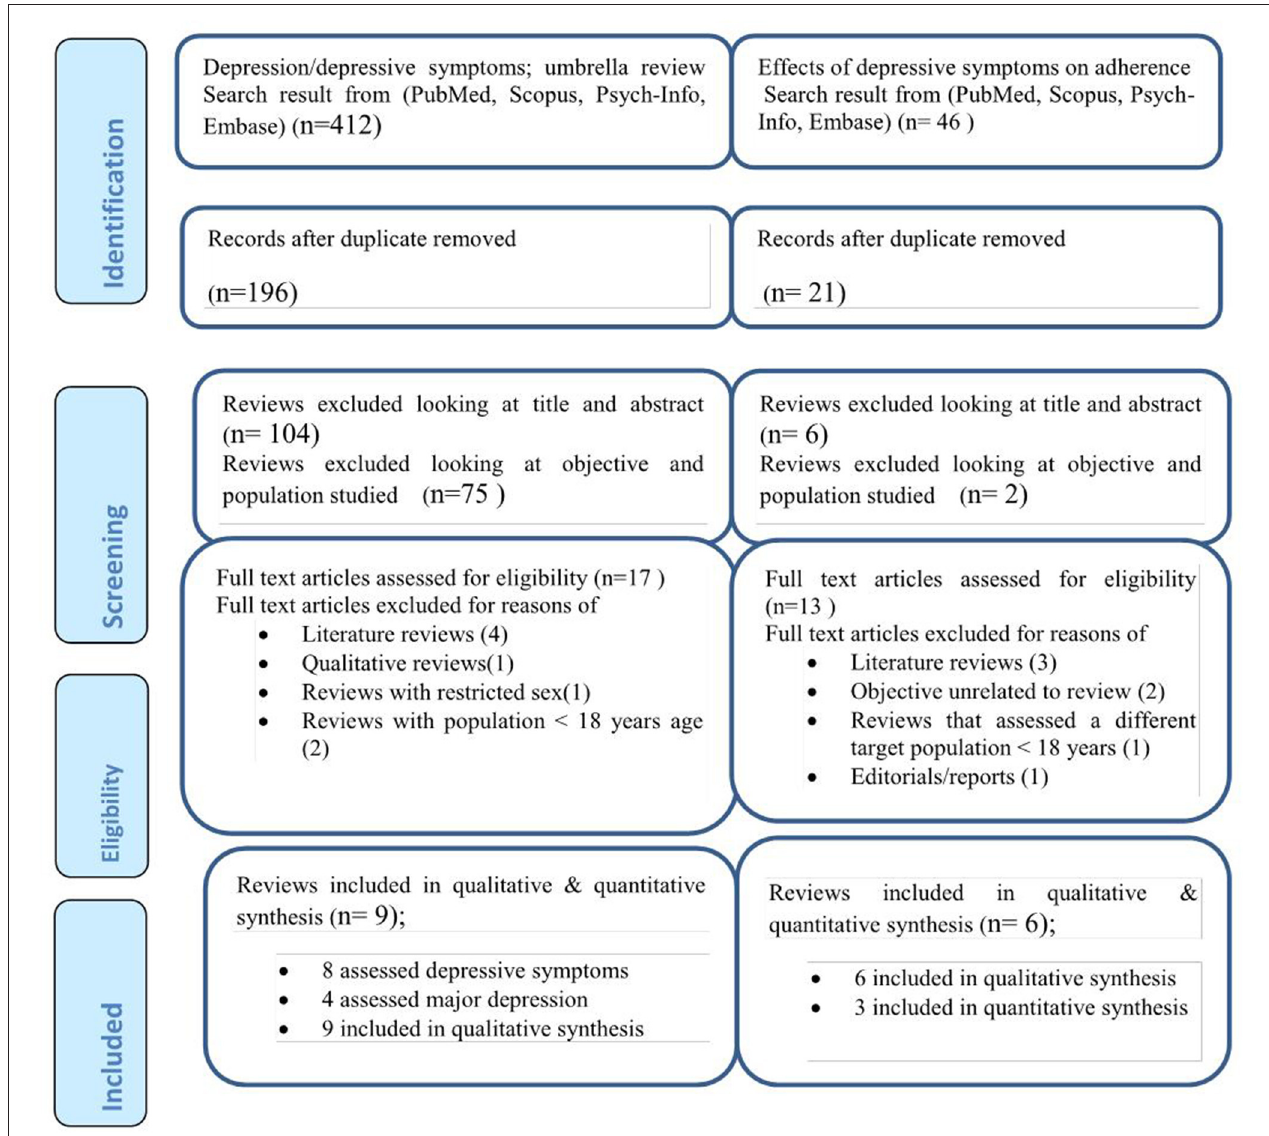
FIGURE 1 | PRISMA flow chart for the review search